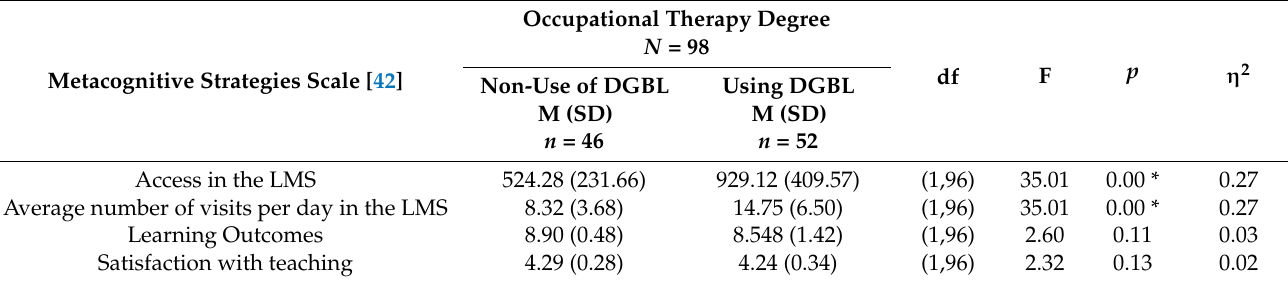
Table 4. One-factor fixed-effects ANOVA (use of DGBL vs. non-use) in the group of students of occupational therapy.